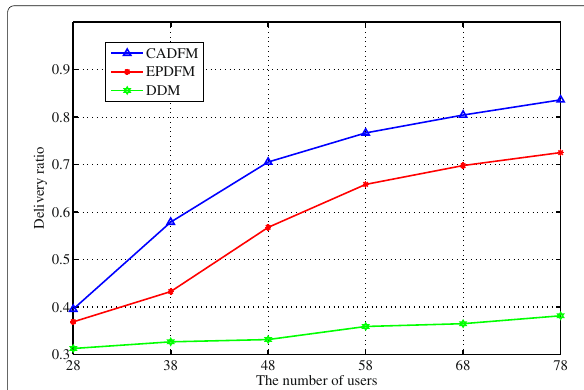
Fig. 4 The successful delivery ratio under various numbers of users